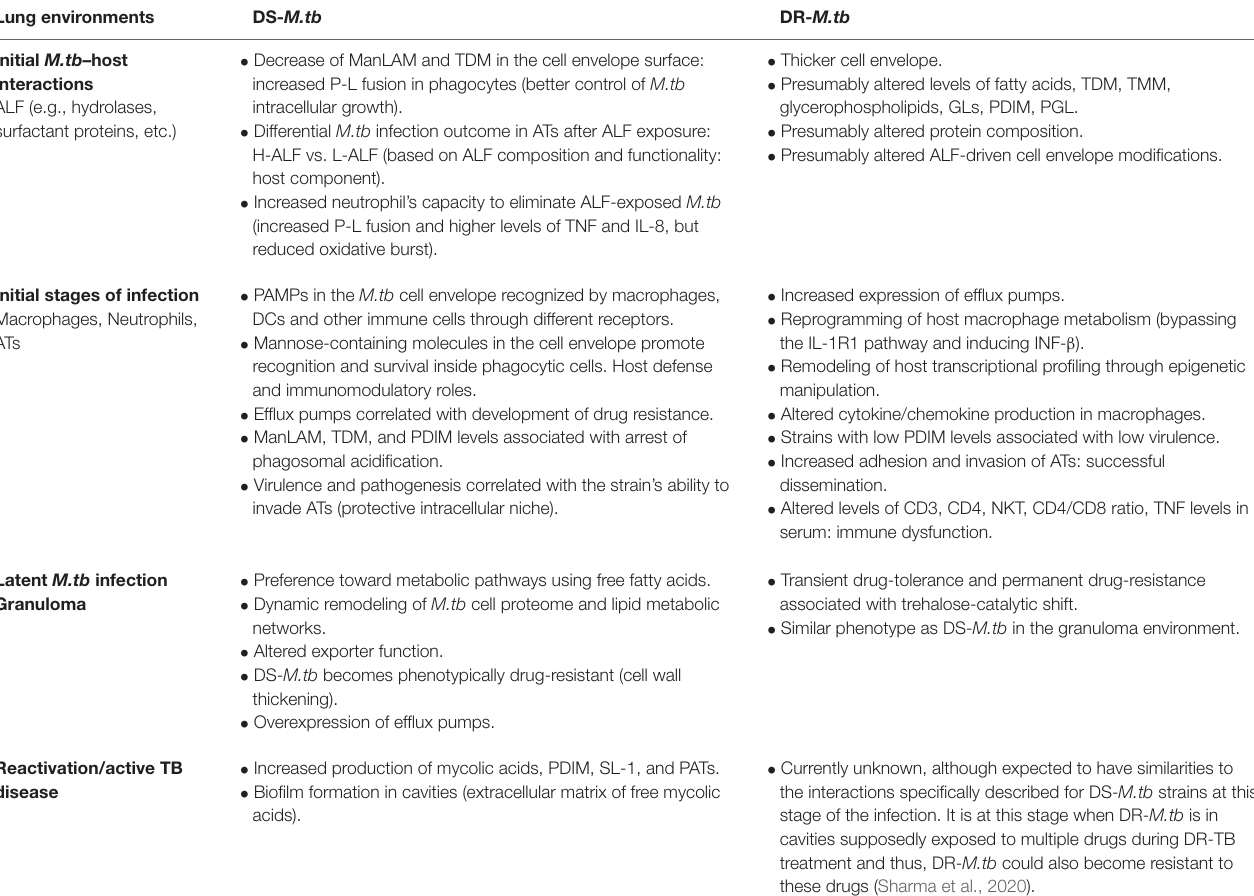
TABLE 1 | DS- M.tb and DR- M.tb interactions with the host at different stages of the infection. Lung environments DS- M.tb DR-